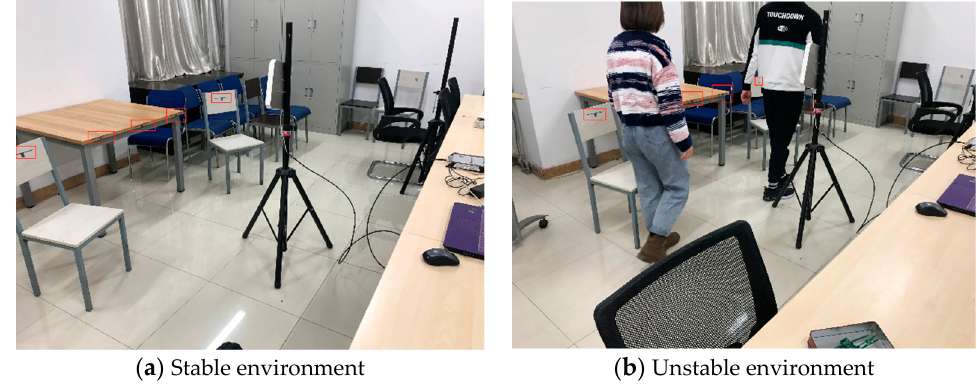
Figure 8. Experimental test scenarios.